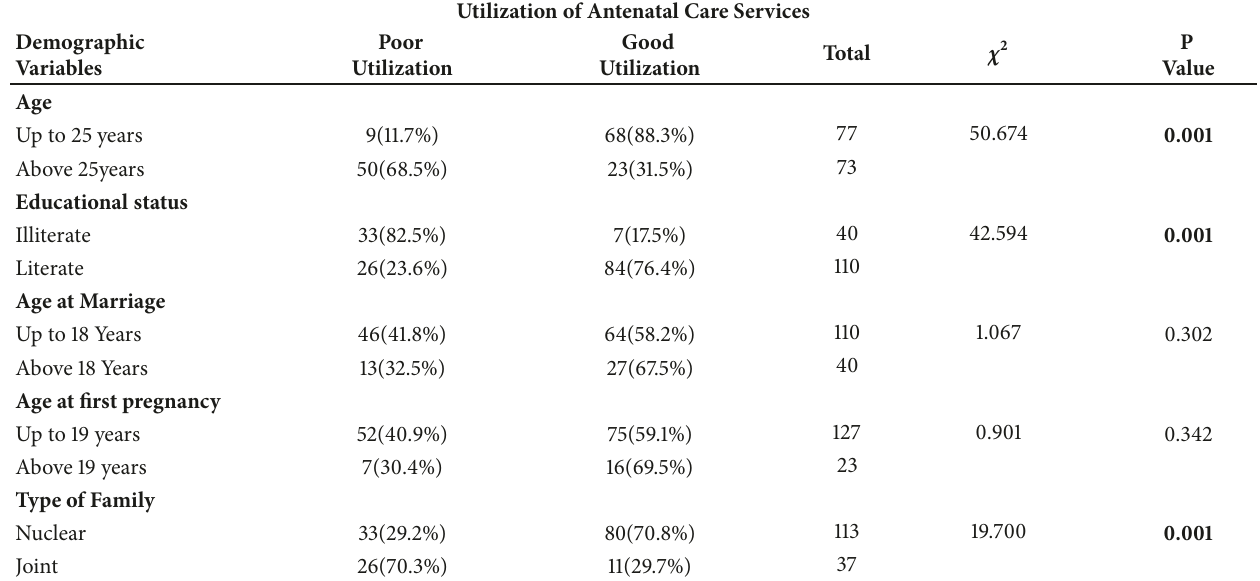
Table 5: Association between sociodemographic variables and utilization of antenatal care